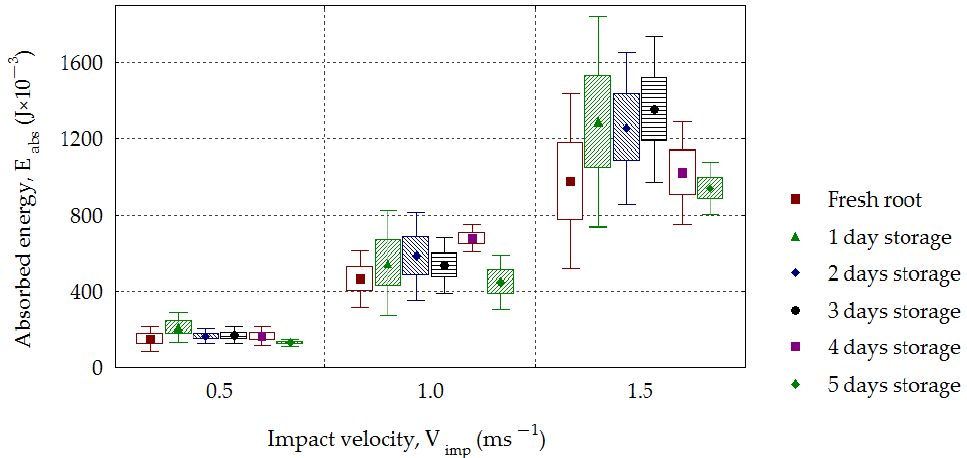
Figure 11. Dependence of absorbed energy ( E abs ) on the impact velocity ( V imp ) for the stored beets.